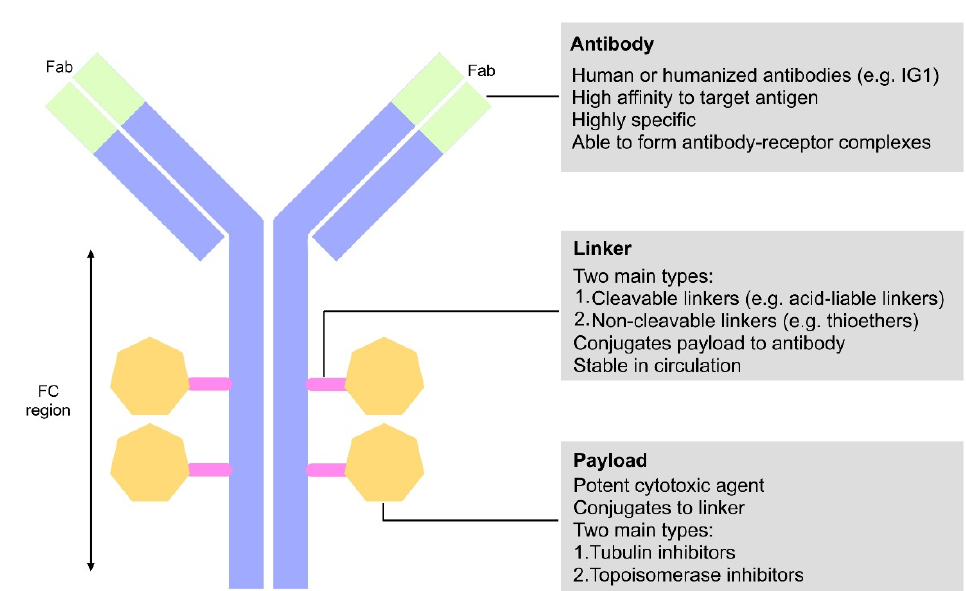
Figure 2. Schematic diagram of an ADC showing the general structure and favorable characteris- tics. The antibody contains antigen-binding sites (F ab ) engineered to recognize target antigens. Pay- loads are connected to the antibody via linkers.